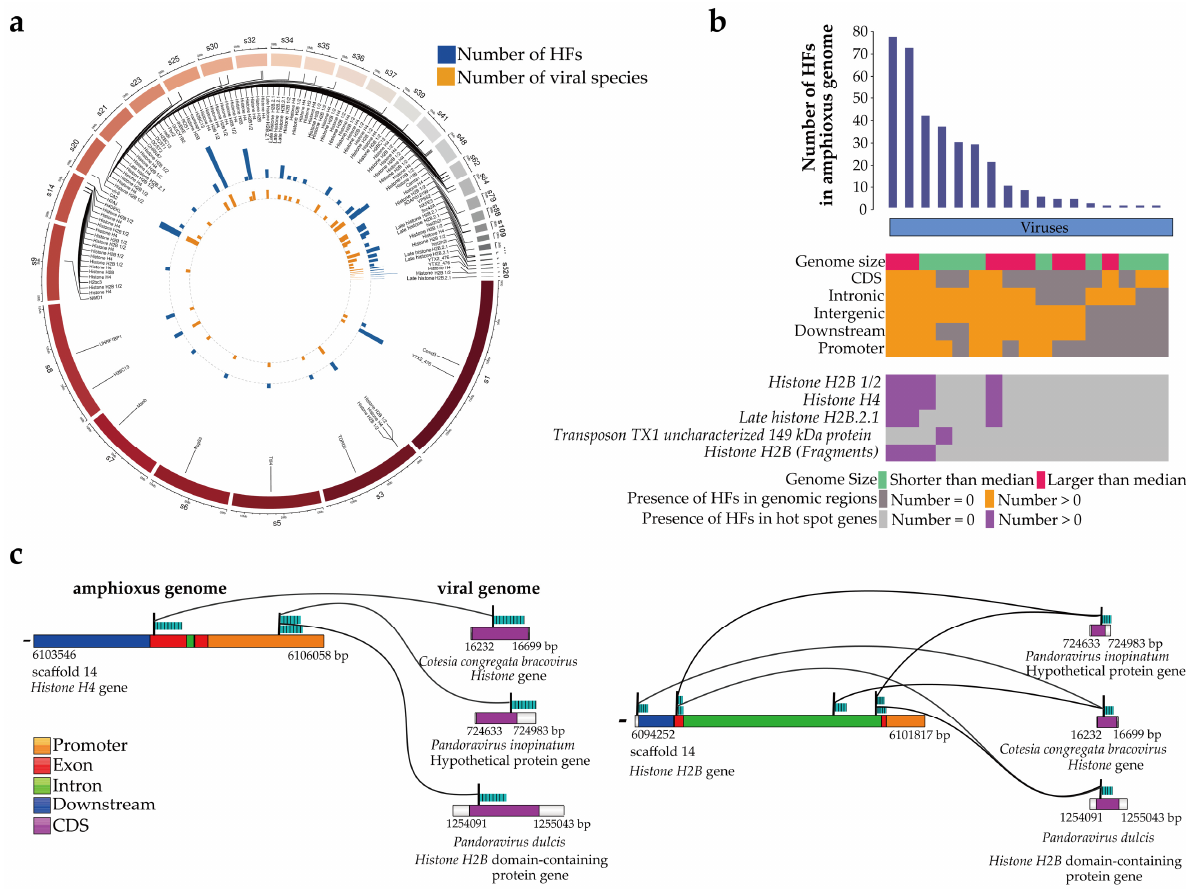
Figure 4. Gene and functional annotation of HFs in the B. belcheri beihai genome. ( a ) The number of HFs and species of virus corresponding to each gene in the B. belcheri beihai genome. The number in the outer circle represents the scaffold id number of the amphioxus genome, and the inner circle shows the amphioxus gene name. The height of the yellow bar represents the number of viruses species. The height of the blue bar represents the number of HFs in amphioxus. ( b ) General profile of HF in the B. belcheri beihai genome when mapped to viruses. Each blue vertical track represents a virus species. The height of blue vertical track represents the number of HFs in amphioxus. All